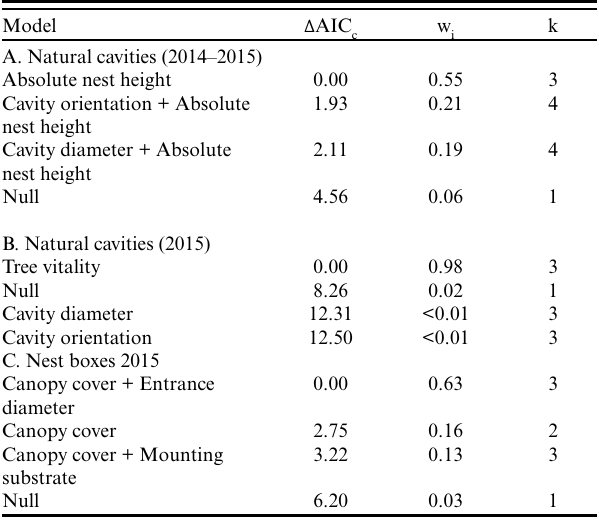
when we limited the only failed nests to those that were depredated, the univariate nest type model was better than the null (null Δ AIC = 3.59), but the 95% CIs of each nest type still c